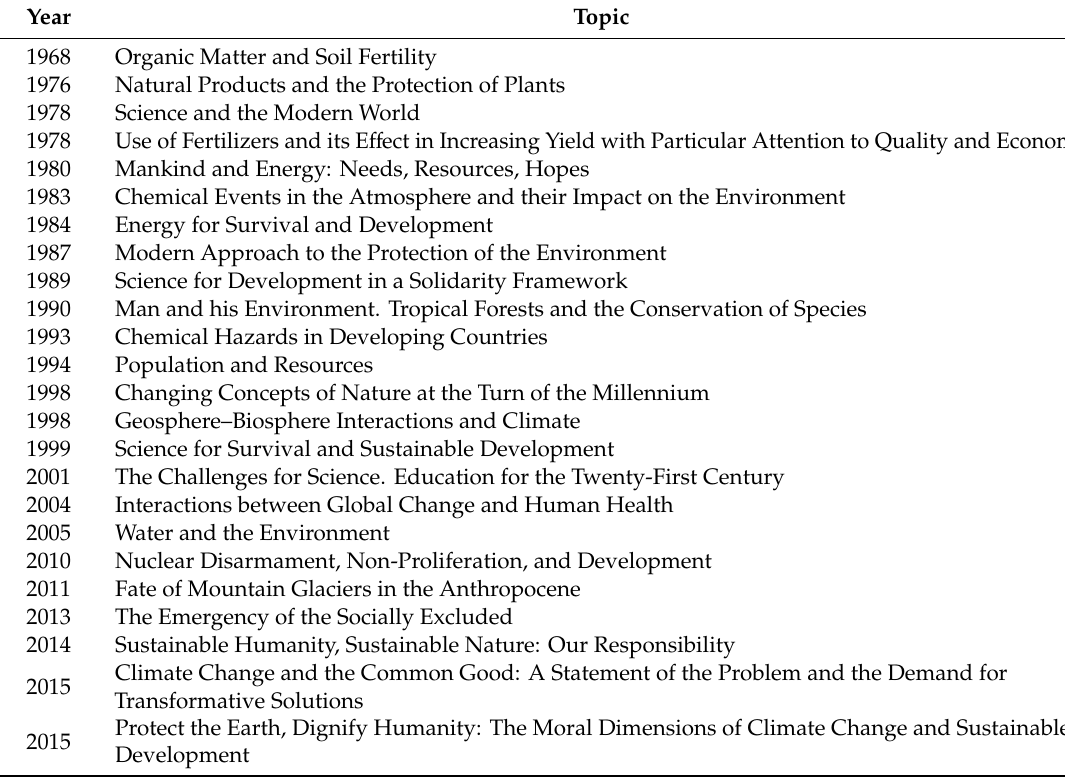
Table 1. Sustainability-related study weeks, study days, symposiums, and working groups organized or sponsored by the Pontifical Academy of Sciences